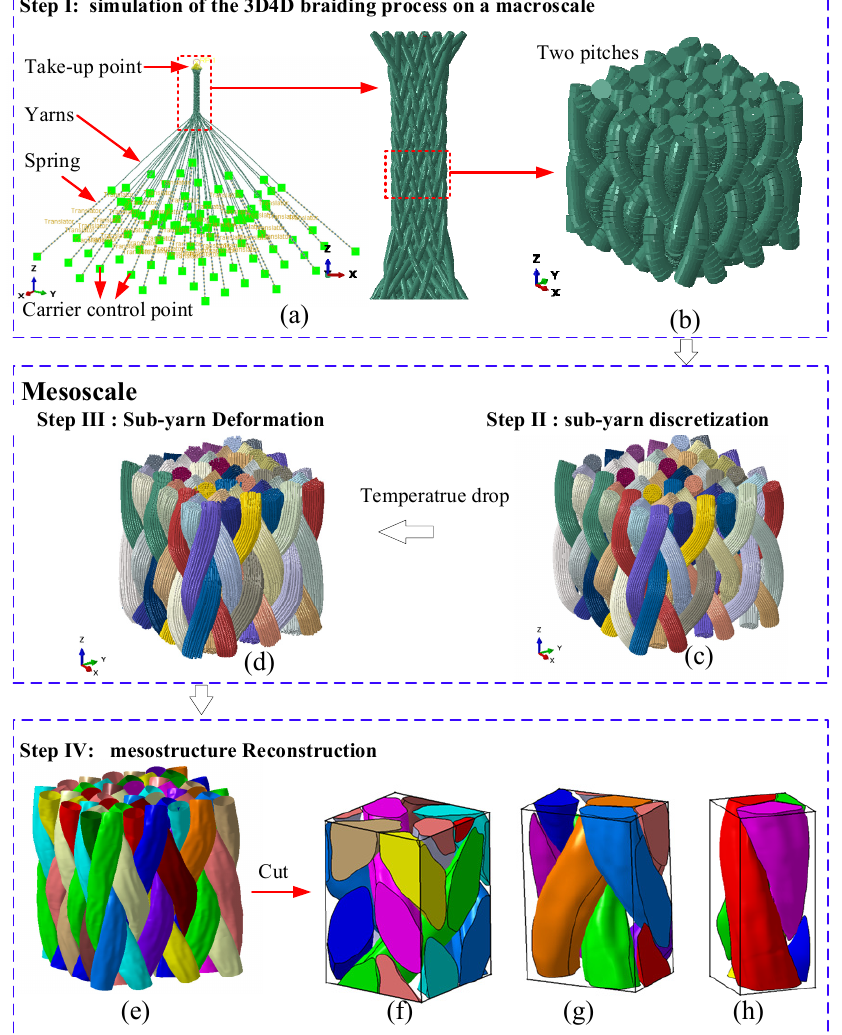
Figure 3. Workflow of the modeling methodology: ( a ) Step I: the simulation model of the braiding process on the macroscale, ( b ) extracting the two pitches fabric in the stable stage, ( c ) Step II: sub- yarn discretization, ( d ) Step III: sub-yarn deforming simulation on the mesoscale, ( e ) mesostructure reconstruction, ( f ) the interior cell, ( g ) the surface cell, and ( h ) the corner cell.